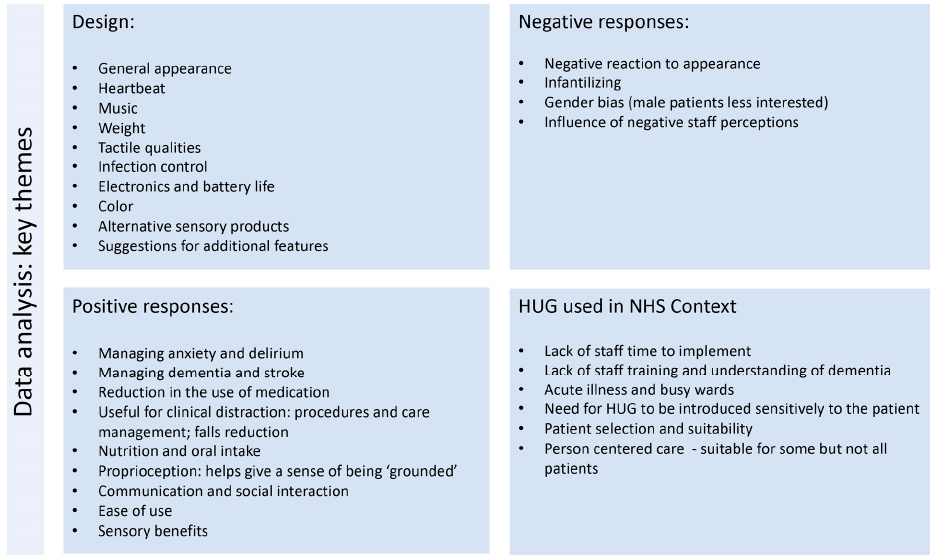
Figure 6. Key themes identified from analysis of the interview transcripts.